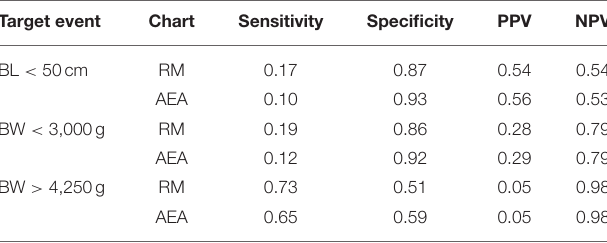
TABLE 2 | Sensitivity, specificity, and positive and negative predictive values for RM and AEA charts corresponding to each target event * (BL < 50cm; BW < 3,000g and BW > 4,250g) in the total sample ( n = 27,613)